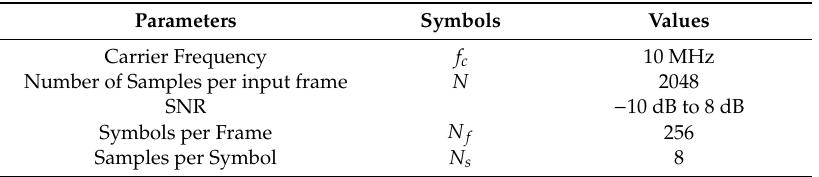
Table 1. Dataset Parameters.